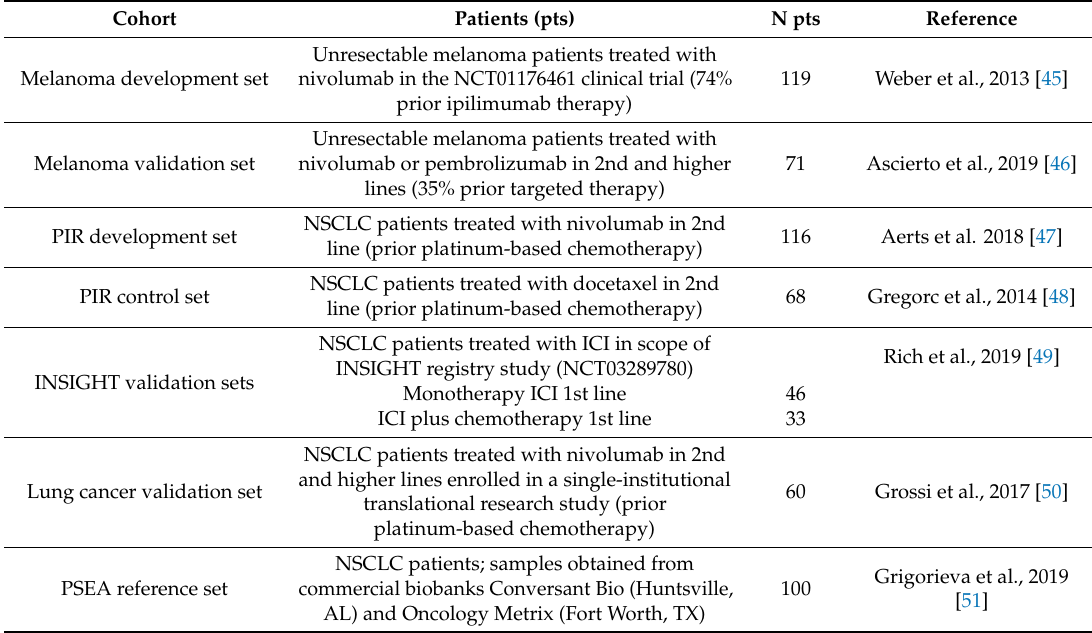
Table 1. Cohorts of